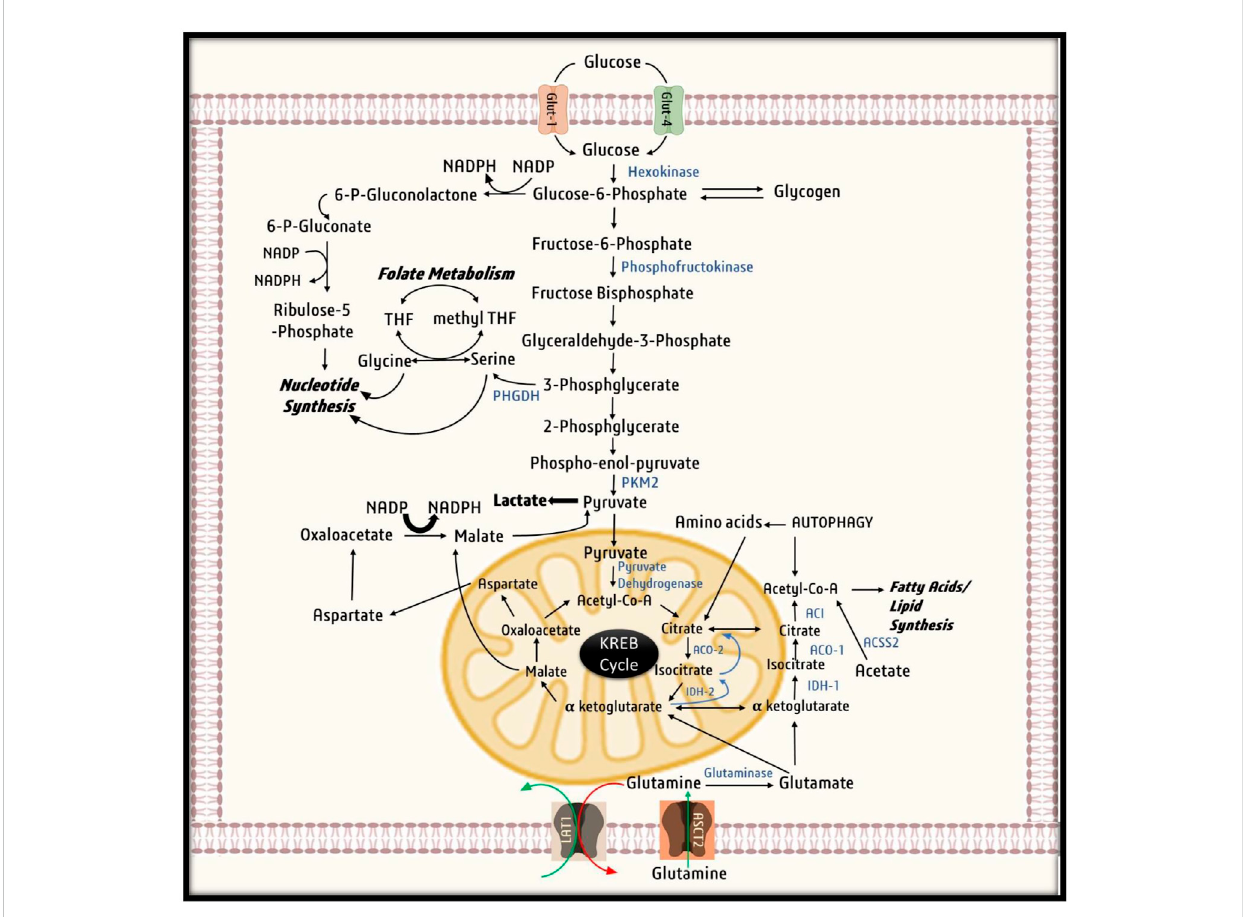
FIGURE 5 Utilization of Glucose by cancer cells. Cancer cell uptake Glucose inside the cell with the help of glucose transporters (GLUTs). Glucose then undergoesglycolysis,in fi rststepofglycolysis,glucoseisconvertedtoGlucose-6-phosphatebyHexokinase,thatisutilizedbycancercellsfornucleotide synthesis and production of NADPH by PPP shunt. When in abundance glucose-6-phosphate is stored in form of glycogen. Glucose -6-phosphate then gets converted to 3-phosphoglycerate to provide for nucleotide synthesis through folate metabolism. Ultimately in the last step of glycolysis, phospho-enol-pyruvateisconvertedtopyruvate.DuetoWarburgeffectpyruvateisconvertedtolactateandexcretedoutofthecell.Undermildhypoxic conditions, pyruvate derived from malate aspartate shuttle and exogenous lactate as well as oxidative metabolism of glutamine runs the Krebs cycle to generate ATP. On the other hand, under severe hypoxia due to activation pyruvate kinase-1, pyruvate does not undergo conversion to citrate instead utilized for other vital process of cell survival. While citrate is aerobically generated from glutamine by conversion of glutamine to glutamate and ultimately to α -ketoglutarate. α -ketoglutarate is further converted by Isocitrate dehydrogenase-2 to isocitrate and then citrate by acoitase-2. Ultimately, citrate is converted to acetylcoA for fatty acid